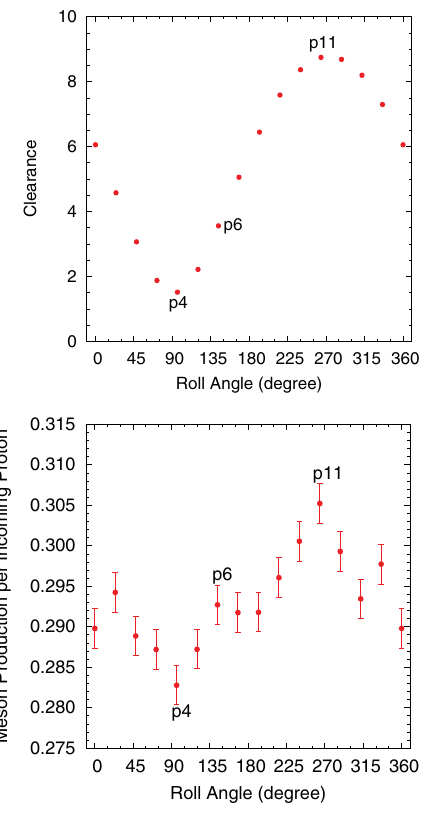
FIG. 10. The clearances (top) and meson production (bottom) for multiple proton beam entry directions relative to the mercury jet at z ¼ (cid:2) 75 cm . Data points for meson production are gen- erated from 4 (cid:3) 10 5 incoming 8-GeV protons.